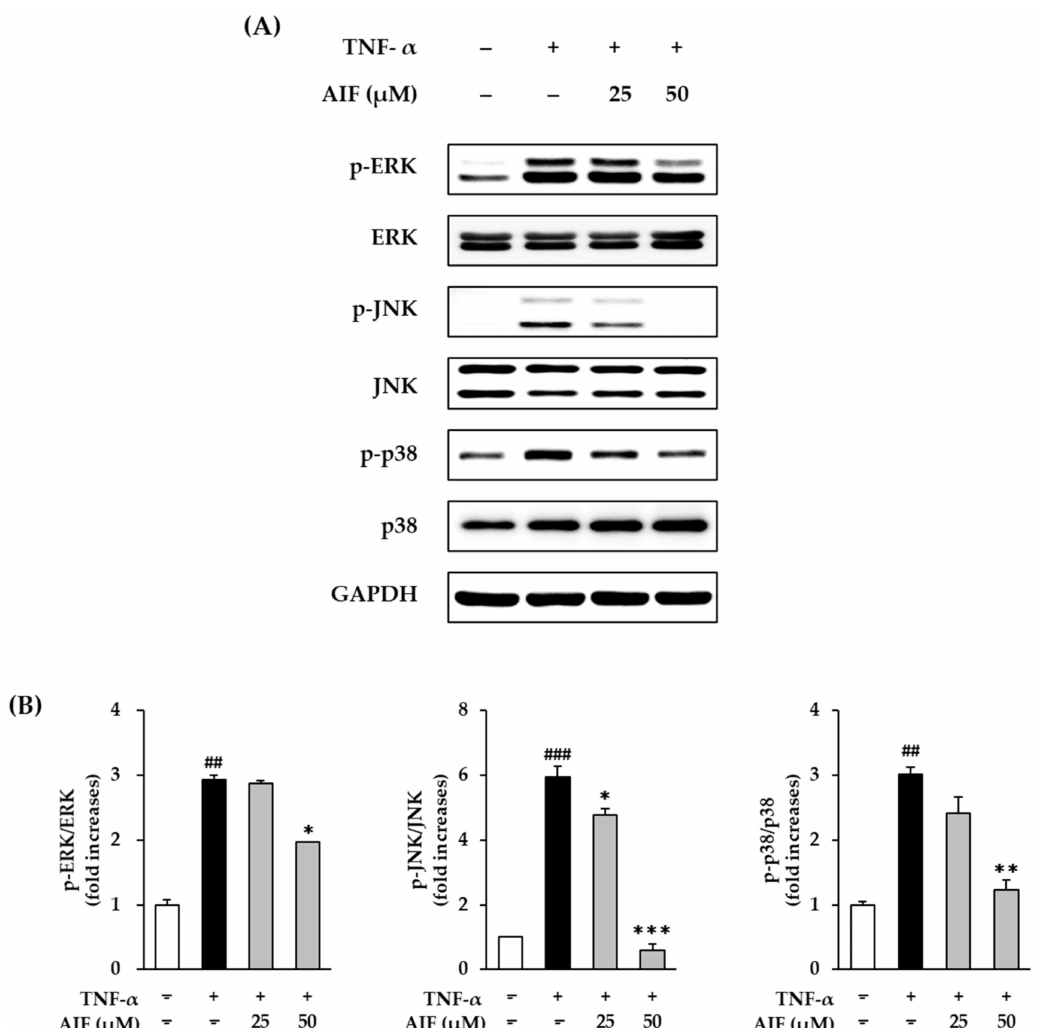
Figure 9. Inhibition of mitogen-activated protein kinase (MAPK) phosphorylation by alpinumisoflavone (AIF) in tumor necrosis factor- α (TNF- α )-treated human dermal fibroblasts (HDFs). ( A ) Expression of p-extracellular signal-regulated kinase (ERK), ERK, p- c-Jun N-terminal kinases (JNK), JNK, p-p38, p38, and glyceraldehyde 3-phosphate dehydrogenase (GAPDH) proteins. ( B ) Relative expression levels of p-ERK/ERK, p-JNK/JNK, p-p38/p38 proteins. HDFs were challenged with 20 ng/mL TNF- α in the presence or absence of AIF (25 and 50 µ M) for 15 min. The protein expression was determined using Western blot analysis. The data are presented as mean ± SEM of at least three independent experiments. ## p < 0.01 and ### p < 0.001 as compared to untreated cells. * p < 0.05, ** p < 0.01 and *** p < 0.001 as compared to TNF- α -treated